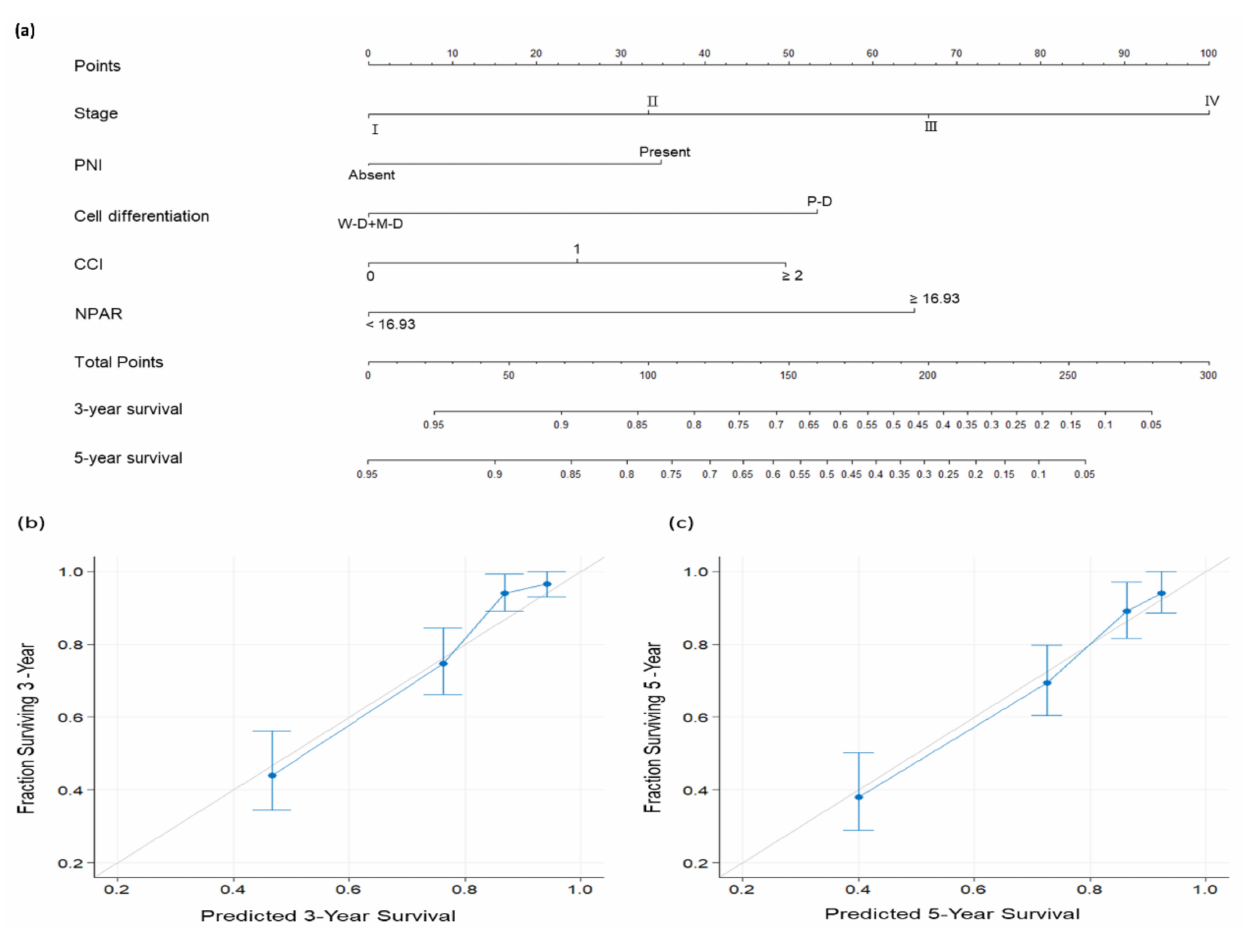
Figure 4. ( a ) Nomogram predicting overall survival (OS) based on neutrophil percentage-to-albumin ratio and prognostic factors identified in multivariate analysis. The degree of risk contributed by each variable is indicated by the line segment and its uppermost points. The total number of points is the sum of each variable’s points. Drawing a vertical line from the calculated total number of points gives the likelihood of 3-year and 5-year OS. Calibration plots for ( b ) 3-year and ( c ) 5-year OS. The gray line at 45 ◦ reflects perfectly accurate prediction; the predictive outcomes of the nomogram are depicted by the blue line. The performance of the nomogram and the 95% confidence intervals for the OS predictions are shown as blue dots with bars, respectively. Abbreviations: CCI, Charlson comorbidity index; M–D, moderately differentiated; NPAR, neutrophil percentage-to-albumin ratio; P–D, poorly differentiated; PNI, perineural invasion; W–D, well